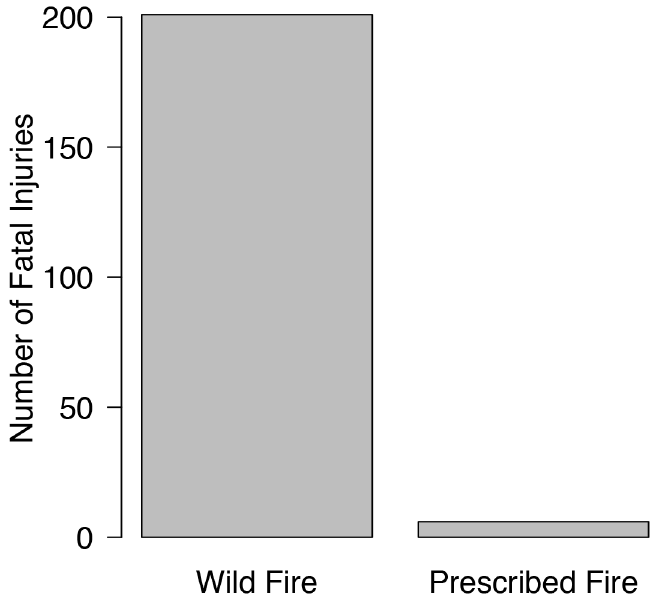
Fig 2. Number of fatal injuries related to wildfire and prescribed fire from 1963 –